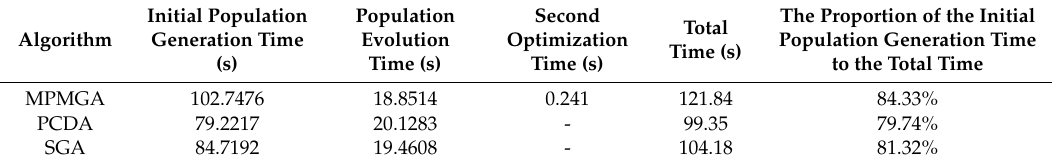
Table 6. Comparison table of the running time of each segment program of the three algorithms.